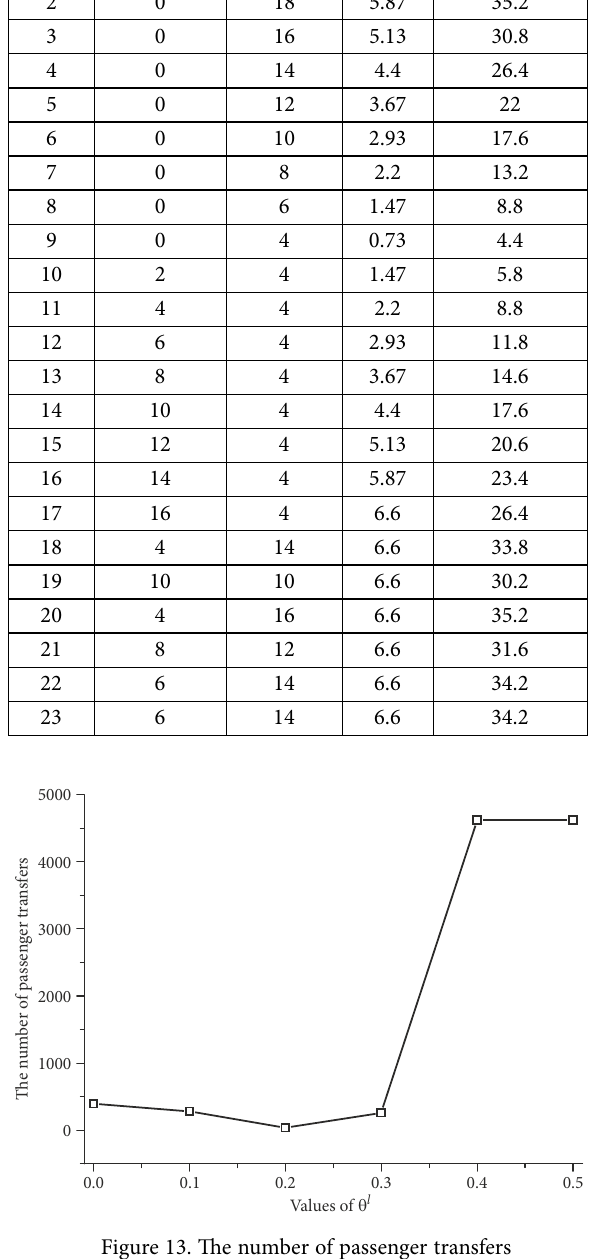
Figure 13. The number of passenger transfers for different values of θ l